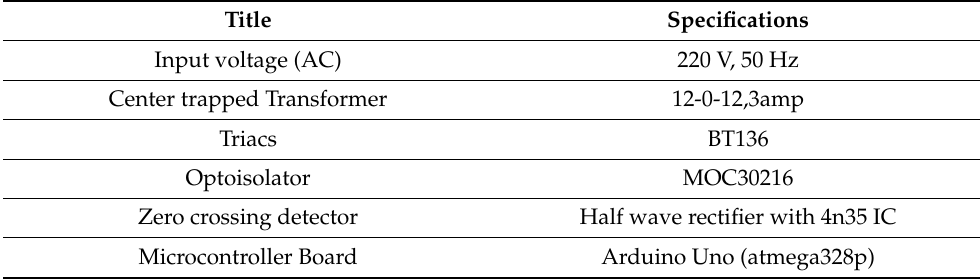
frequency for motor load. ( a ) voltage; ( b )